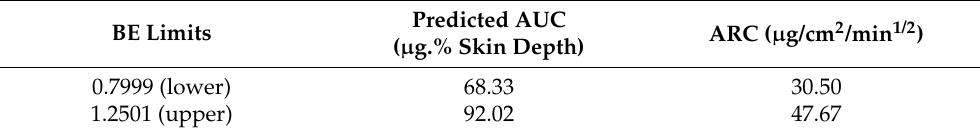
Table 2. BE limits for AUC and